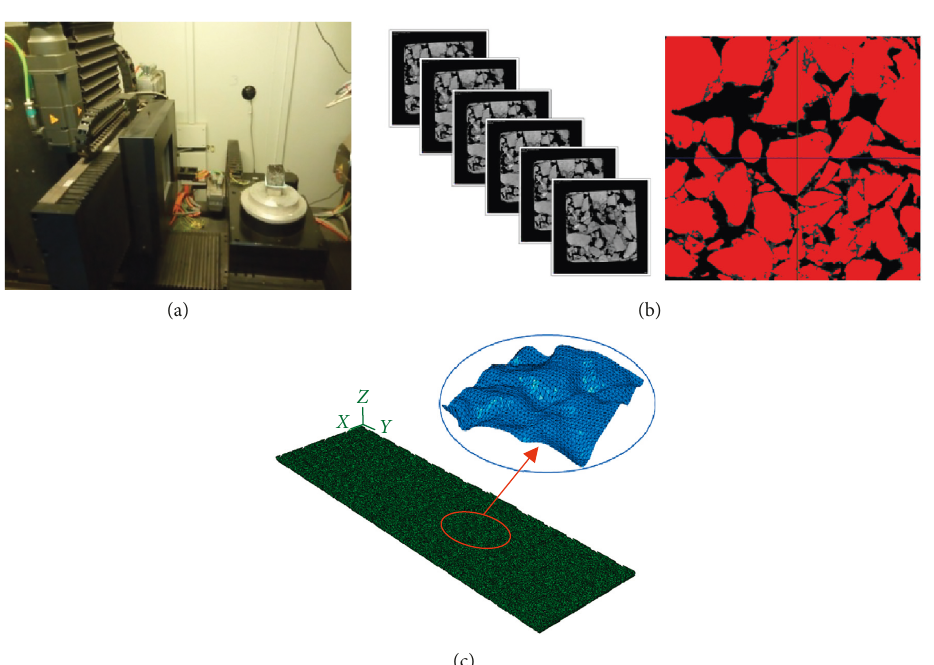
Figure 2: Procedures of modeling asphalt pavement: (a) scanning by the X-ray tomography; (b) threshold segmentation of the specimen images; (c) FE model of the asphalt